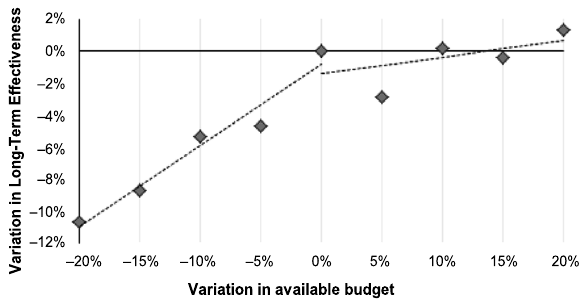
Fig. 5. Variation of LTE with total present value of available budget